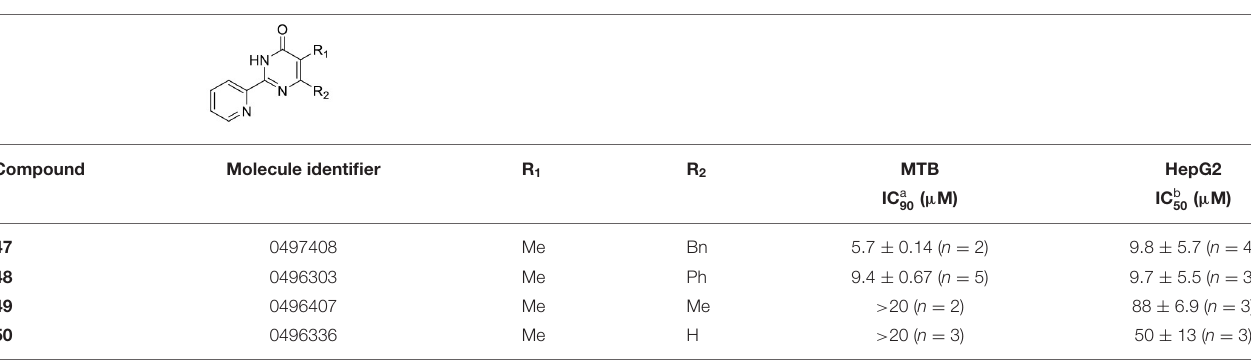
TABLE 3 | Activity of compounds with 2-(pyridin-2-yl)pyrimidin-4(3H)-ones.